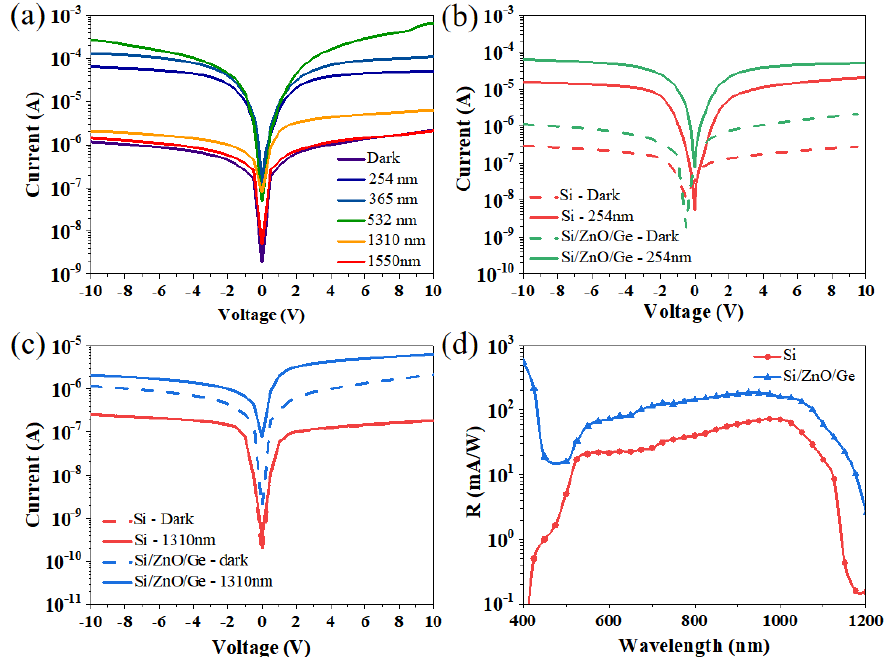
Figure 4. ( a ) I-V characteristics of the Si/ZnO NWs/Ge QDs PD in the dark and under UV-vis-Nir light illuminations (the optical powers are 2.3, 3.7, 7.9, 16, and 23.5 mW for 254, 365, 532, 1310, and 1550 nm, respectively). I-V characteristics of Si and Si/ZnO NWs/Ge QDs PD under 254 nm ( b ) or 1310 nm ( c ) light illumination. ( d ) The responsivity of Si and hybrid PD as a function of wavelength of illuminated light at −8 V reverse voltage . Table 1. The performances of Si/ZnO/Ge PD and perviously reported hybrid PDs. PDs Wavelength (nm) Responsivity